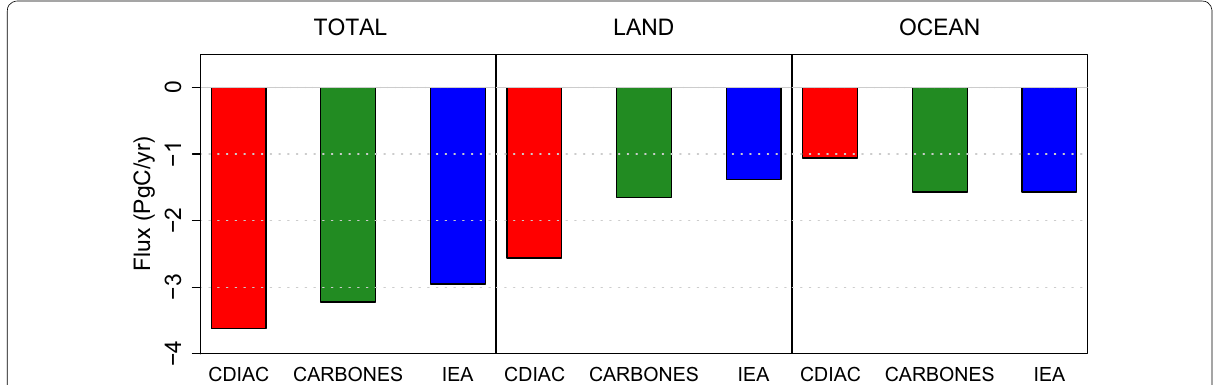
Fig. 6 Bar plot of global total, land and ocean sinks by inverse modelling for three different anthropogenic emission inventories, averaged over 2002–2011. The mean FFC CO 2 emissions were 8.23 inventories